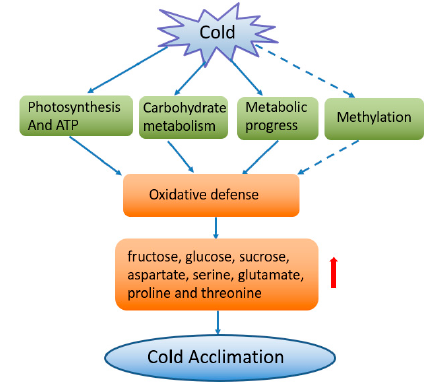
Figure 9. Schematic diagram of proteins involved in cold acclimation in wucai. Plants enhanced cold tolerance by the regulation of several crucial pathways, and led to the alteration of redox homeostasis. It induced soluble sugars and amino acid accumulation, thus facilitating cold acclimation. The solid arrows indicate known activation and the ( ... .) indicate unclear e ff ects. The red arrow indicates an increase in the osmolyte